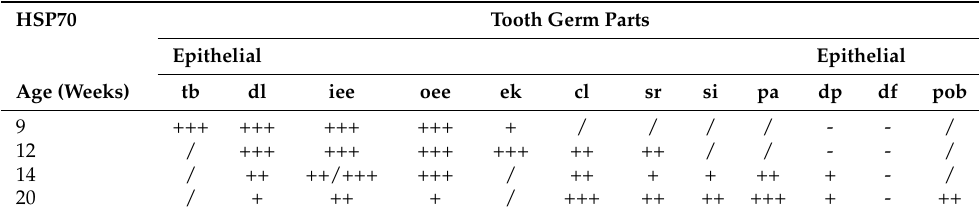
Table 5. Expression of heat shock protein 70 (HSP70) in the epithelial and mesenchymal parts of the tooth germ between the 9th and 20th developmental week